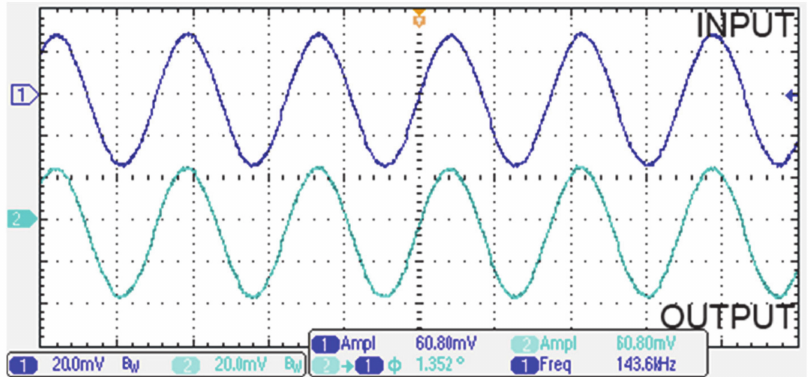
Figure 18. Time-domain BPF input and output experimental voltage